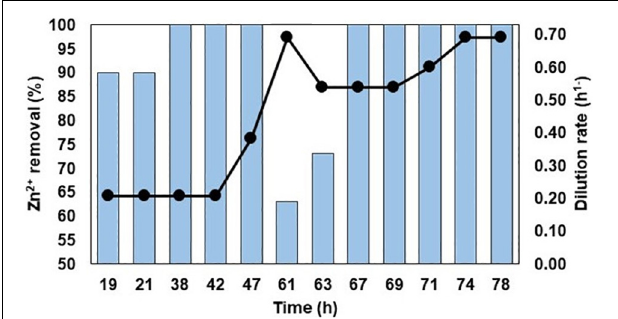
FIGURE 6 | In-line treatment of MIW from Force Crag. The bars represent percentage removal of Zn 2 + , and the line graph depicts changes in dilution rates.